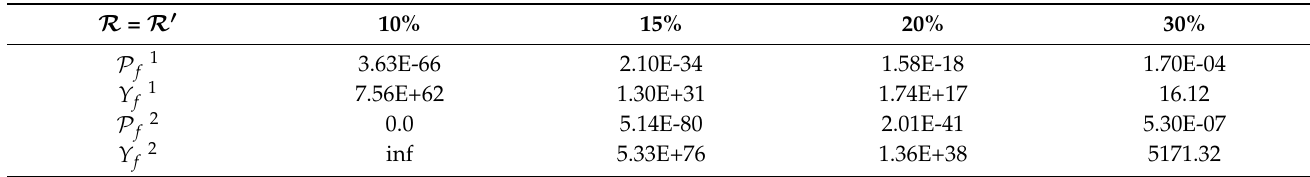
Table 3. Probability of conquering the protocol.